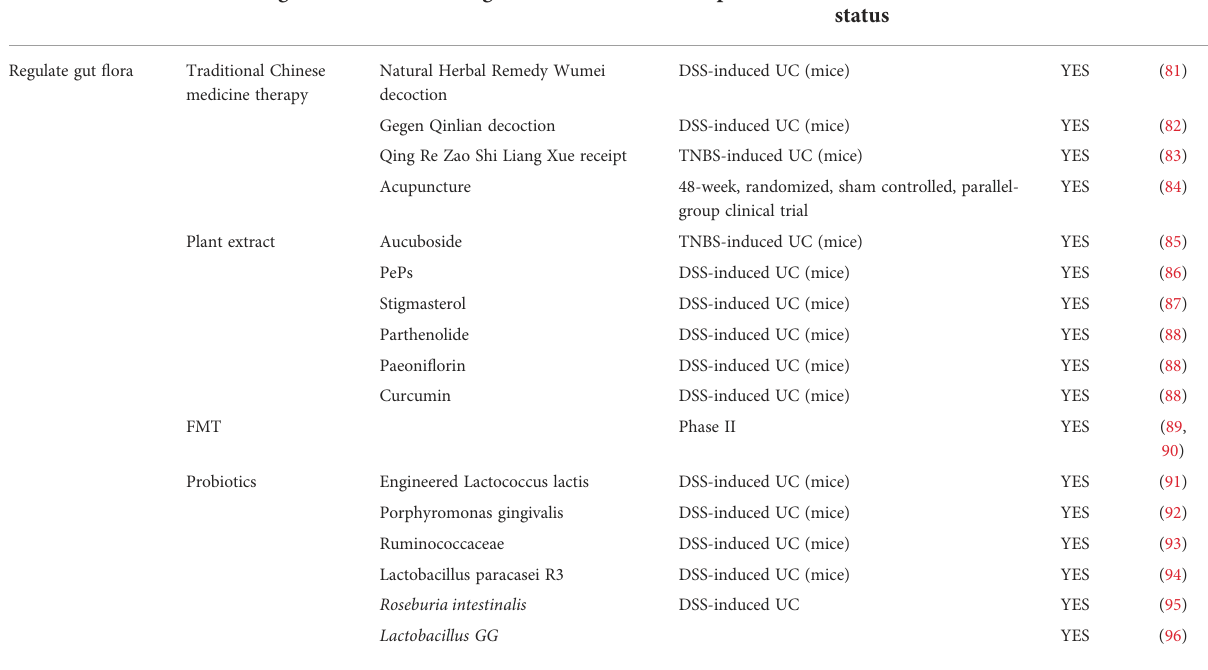
TABLE 2 Potential approaches and therapeutic effect of targeting Th17 cells for IBD.